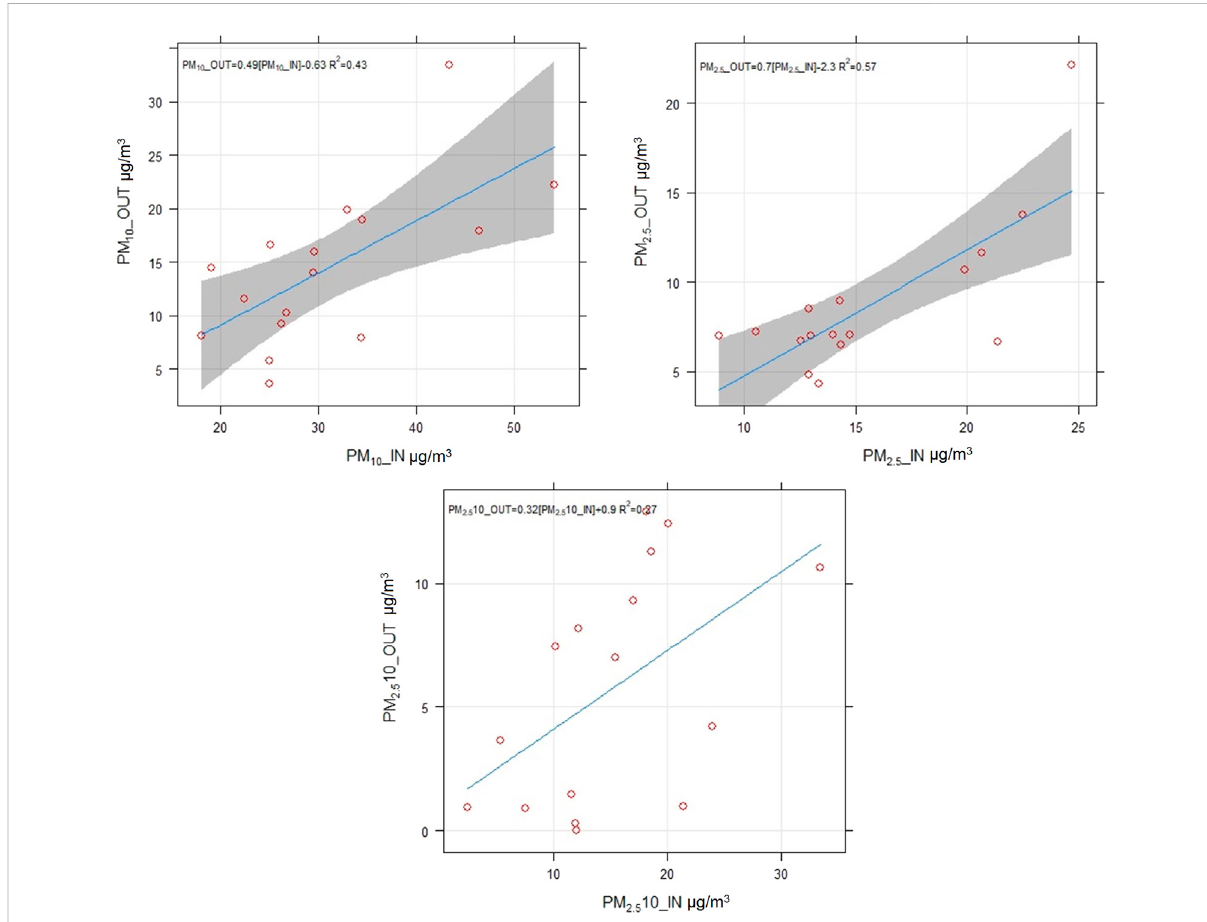
FIGURE 4 Results oftheregressionanalysis performed forPM 10 ,PM 2.5 ,andPM 2.5-10 concentrations during measurementsinthePova ž skýChlmec tunnel (IN — inside the tunnel, OUT — outside near the tunnel